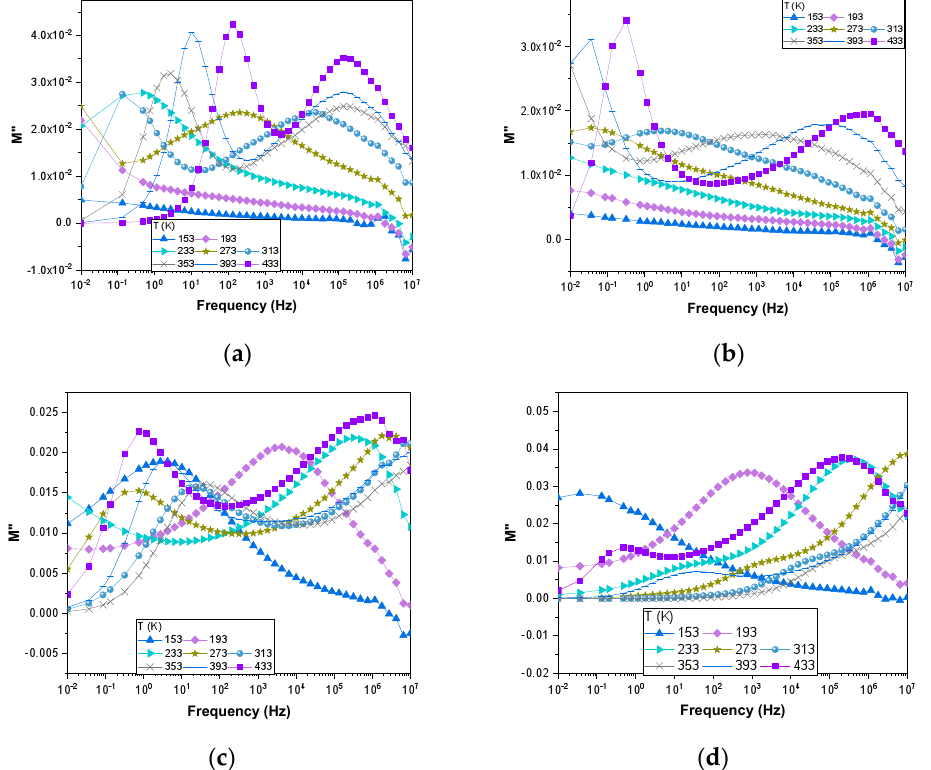
Figure 8. Variations in imaginary part of modulus with frequency with temperature for ( a ) PPDA and PPDA/MMT composites: ( b ) PPDA − 5, ( c ) PPDA − 35 and ( d ) PPDA − 50.